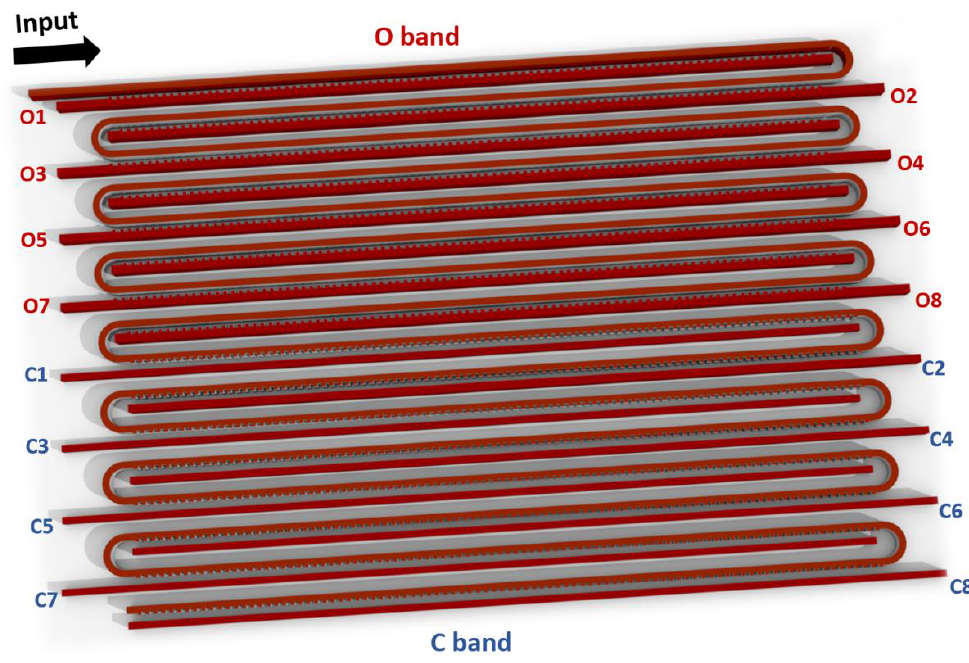
Figure 1. Single-channel grating structure diagram. Broad-spectrum light is input from the input port, the light is transmitted along the main waveguide, and is coupled to the output waveguide at a position that satisfies the wave vector matching condition.